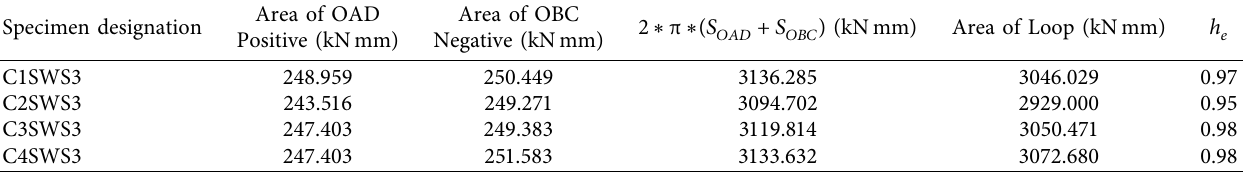
Table 10: Cumulative energy dissipation and EVD of connection type.